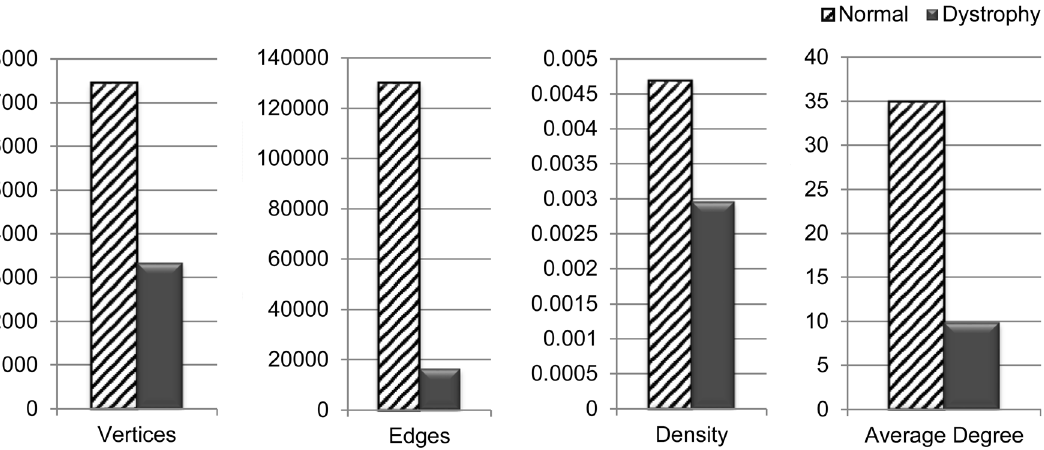
Figure 1. Structural Properties- Normal vs. Dystrophy Interaction Networks. Plots of the number of Vertices, number of Edges, Density and Average Degree of the Normal and DMD interaction networks that were constructed from the GSE6011 dataset [discussed in Methods Section]. The scales (y-axis) for these structural properties are different and the data for the networks are color coded as green and red for the Normal and DMD muscles respectively.